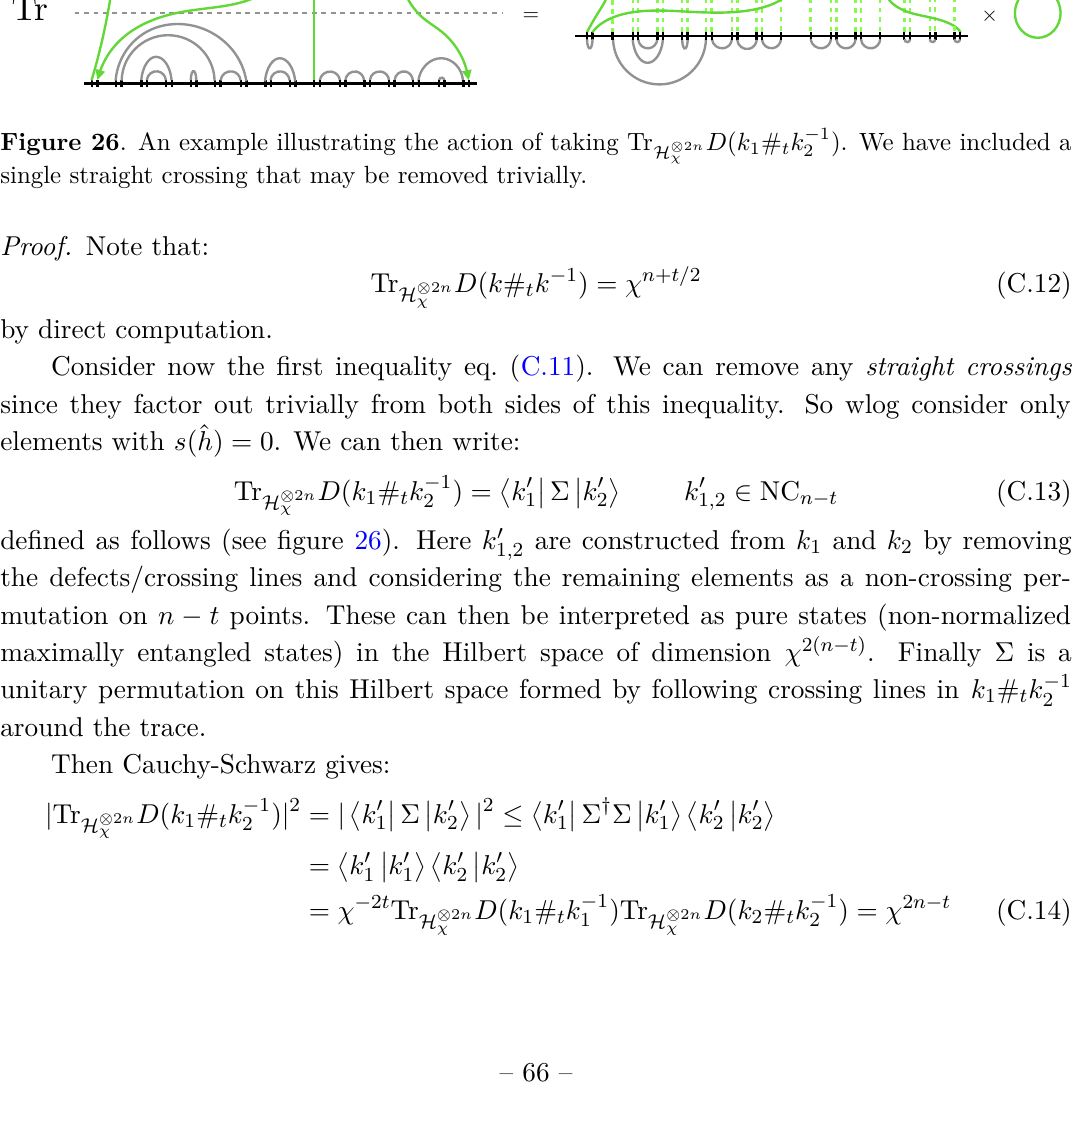
Figure 25 . The procedure for constructing k 1 # t k − 1 crossings.